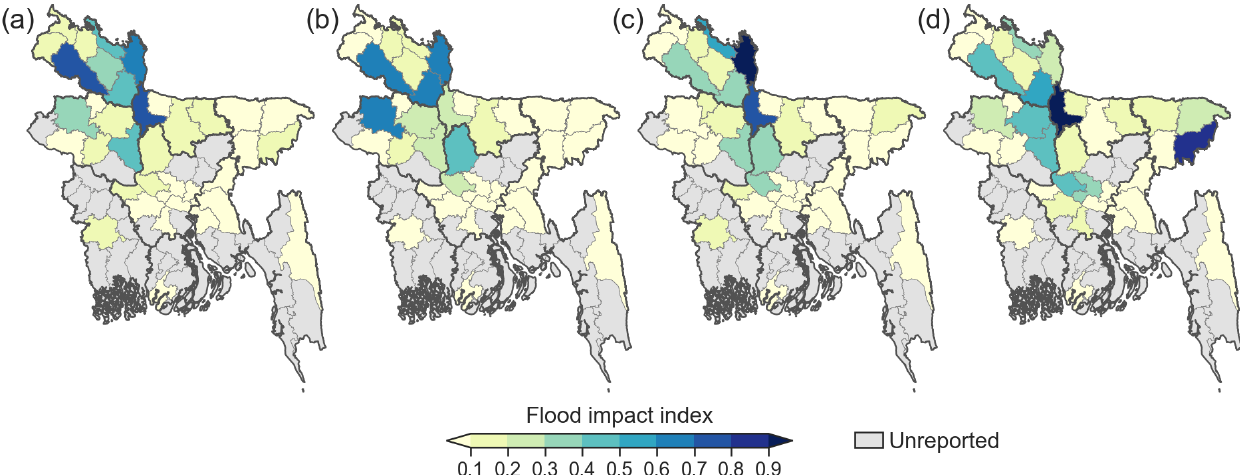
Figure 7. Impact index maps of the August 2017 flood event for (a) distress, (b) damage, (c) disruption, and (d) health.